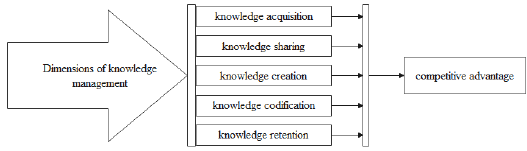
Figure 1. The Proposed Model